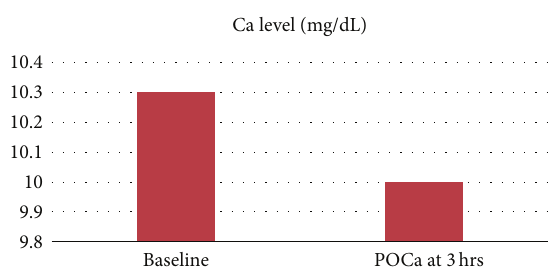
Figure 1: Perioperative PTH monitoring, POPTH (postoperative PTH), and Pg/mL (picograms/milliliter).